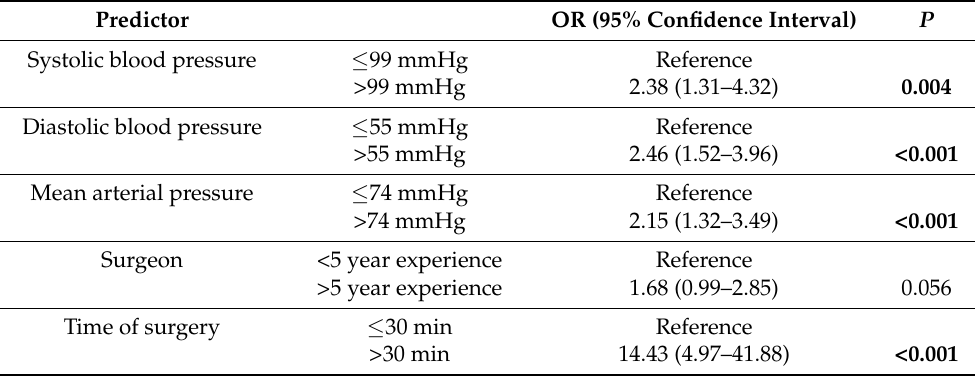
Table 2. Univariate logistic regression. Cut-off values were selected to obtain maximum values of sum of sensitivity and specificity in ROC